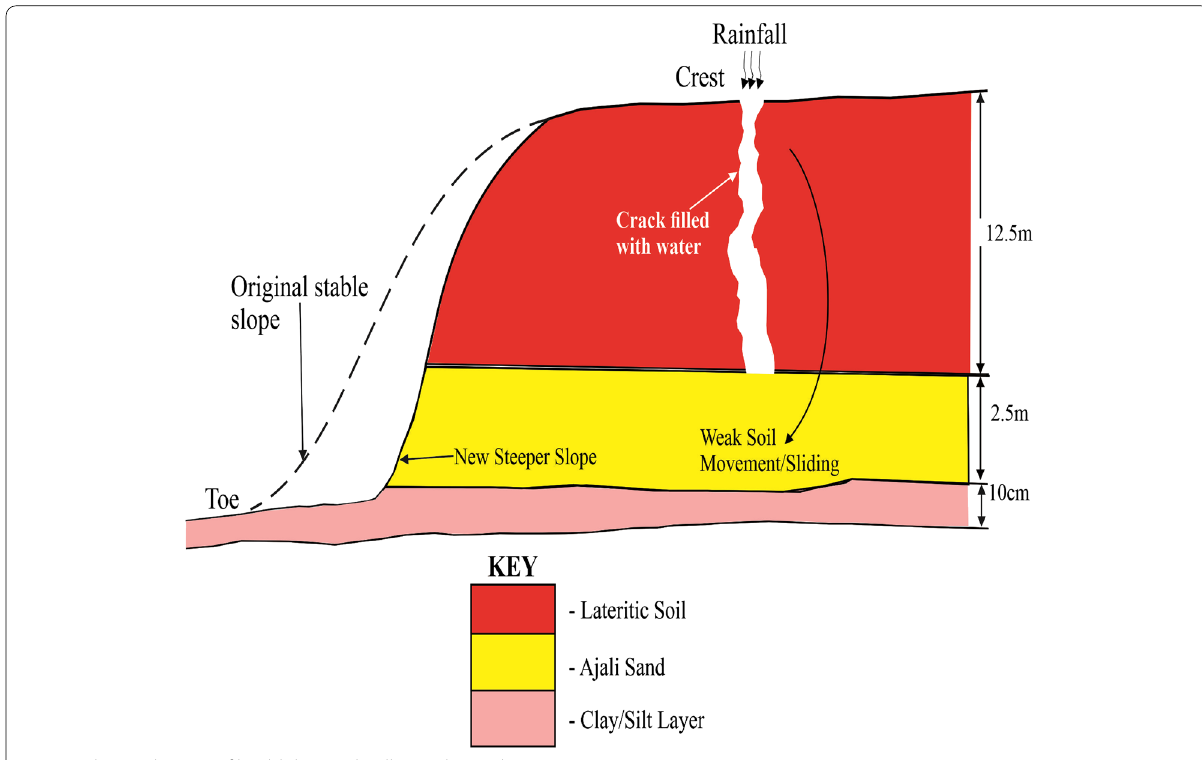
Fig.10 The mechanism of landsliding and gullies in the study